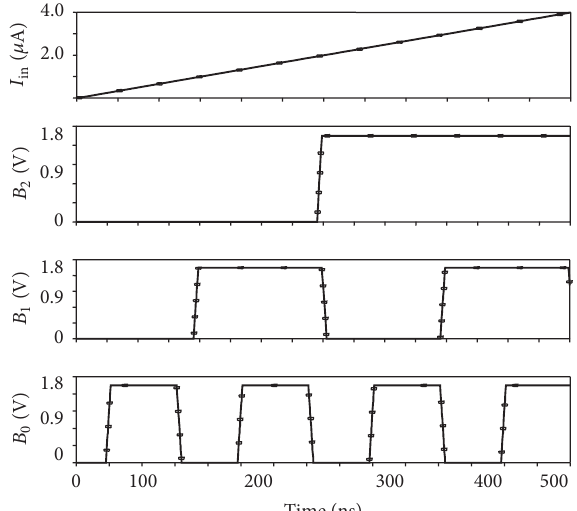
Figure 9: CM flash ADC output for ramp input.